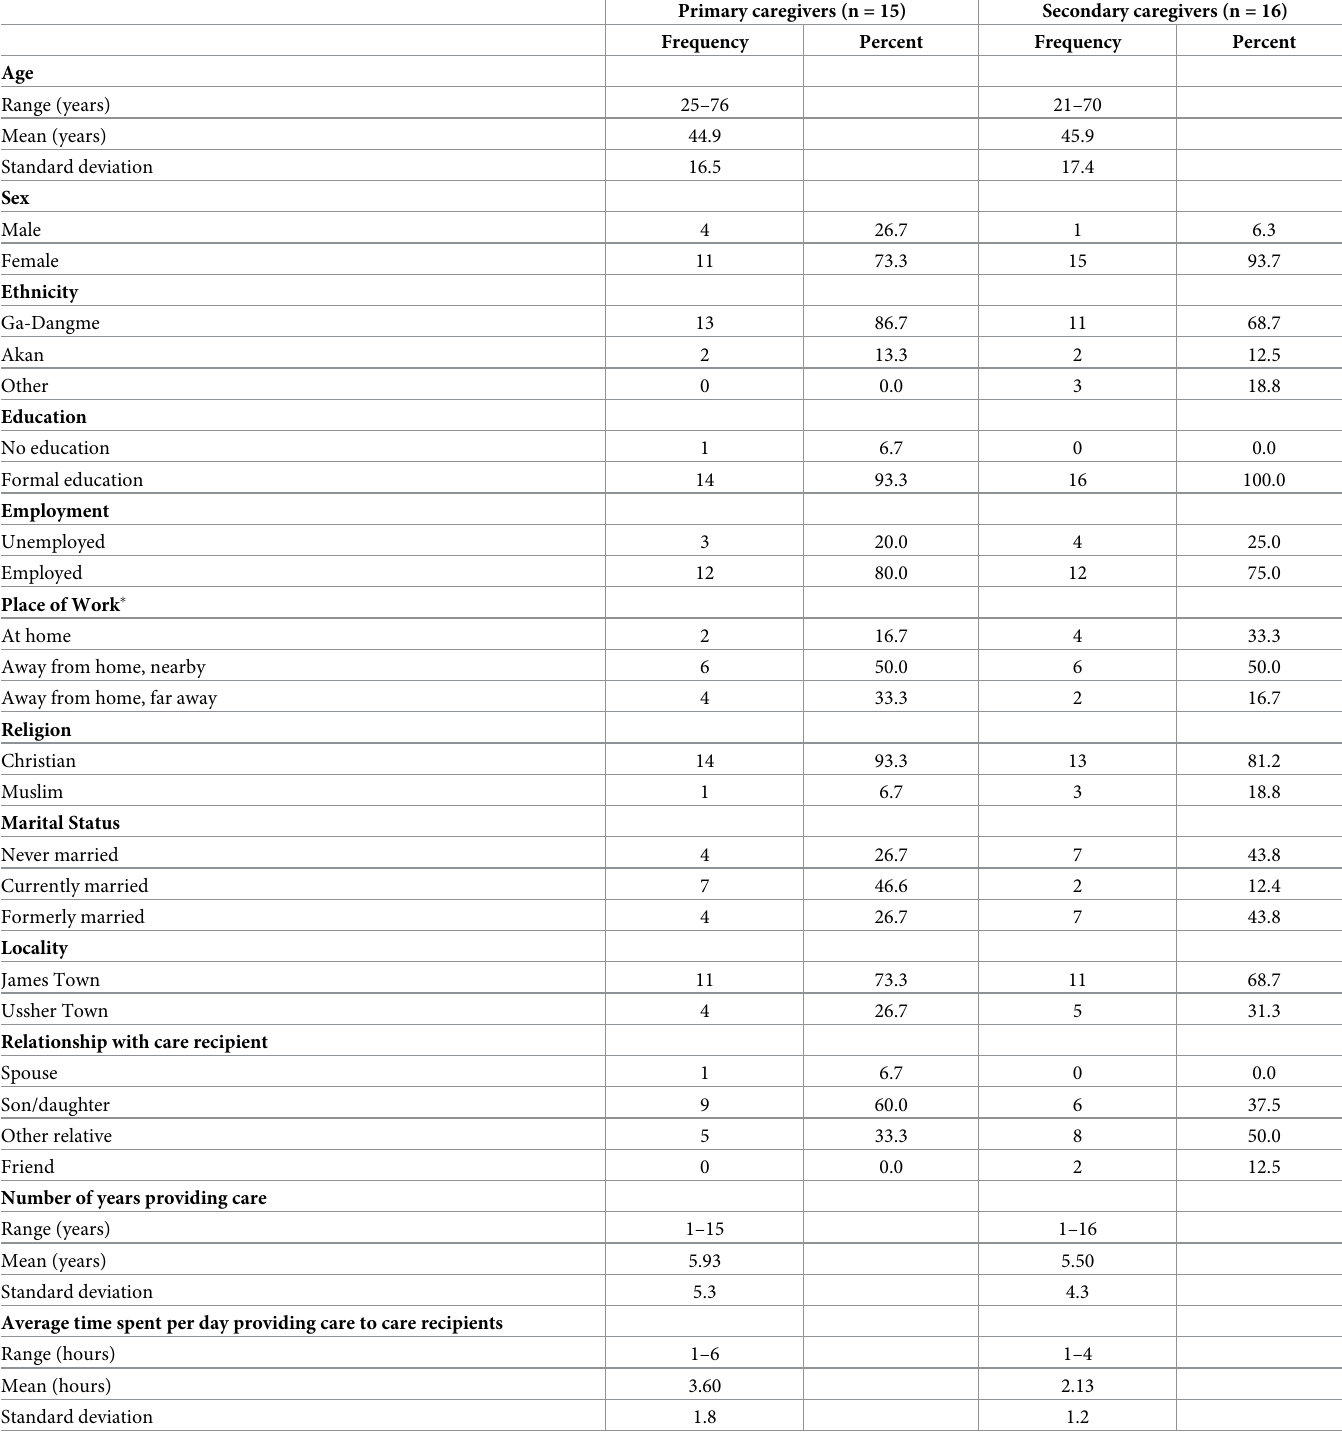
Table 1. Characteristics of family